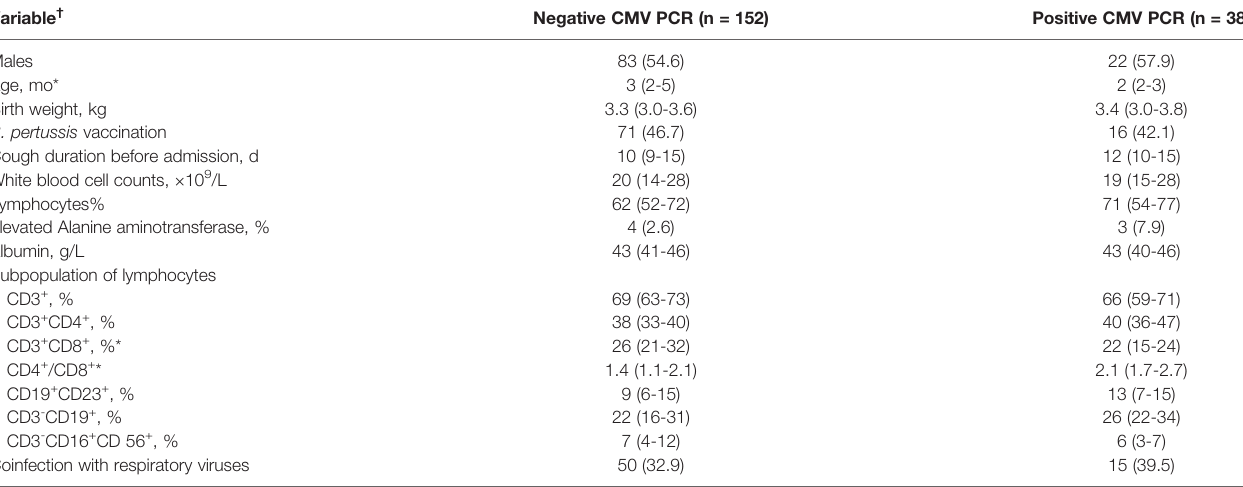
TABLE 2 | Clinical characteristics, laboratory values and their associated cytomegalovirus (CMV) PCR results in plasma. Variable †